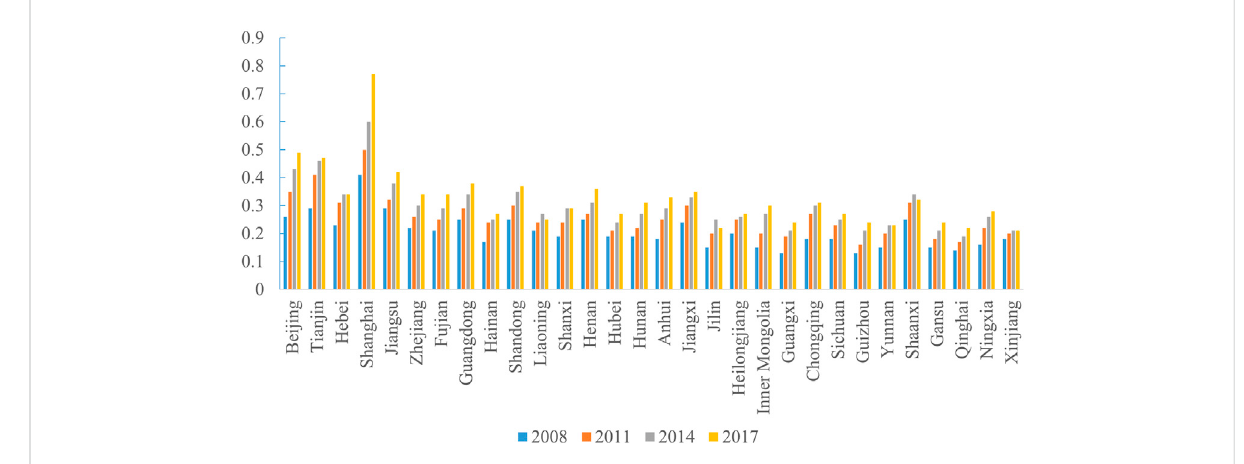
FIGURE 2 Intensive land use of China in 2008, 2011, 2014, and 2017.